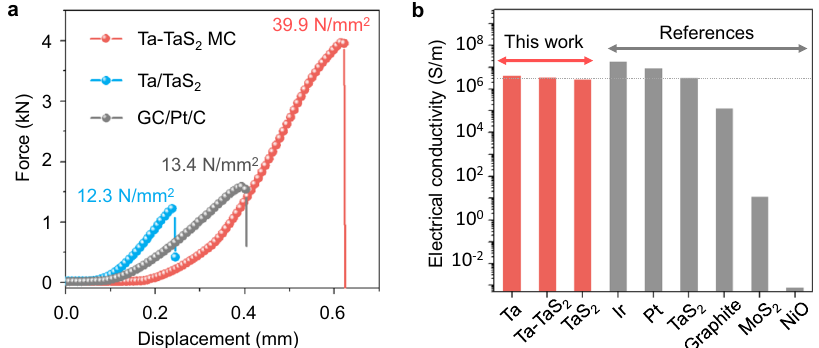
Fig. 3 Mechanical and electrical properties of the Ta-TaS 2 MC. a Force-displacement curves for Ta-TaS 2 MC, Ta/TaS 2 , and a commercial Pt/C bound to glassy carbon for comparison. b Electrical conductivity of different